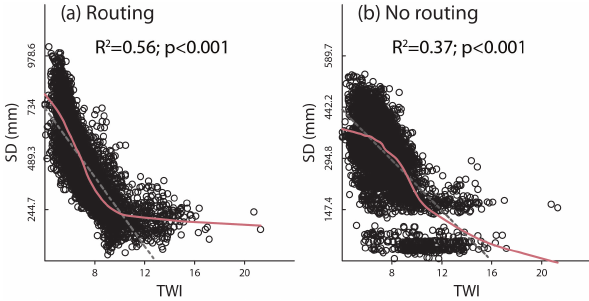
Fig. 8. Comparison of the relationships of simulated saturation deficit (SD) to topographic wetness index (TWI) across the water- shed between the two simulations: (a) considering water routing and (b) ignoring water